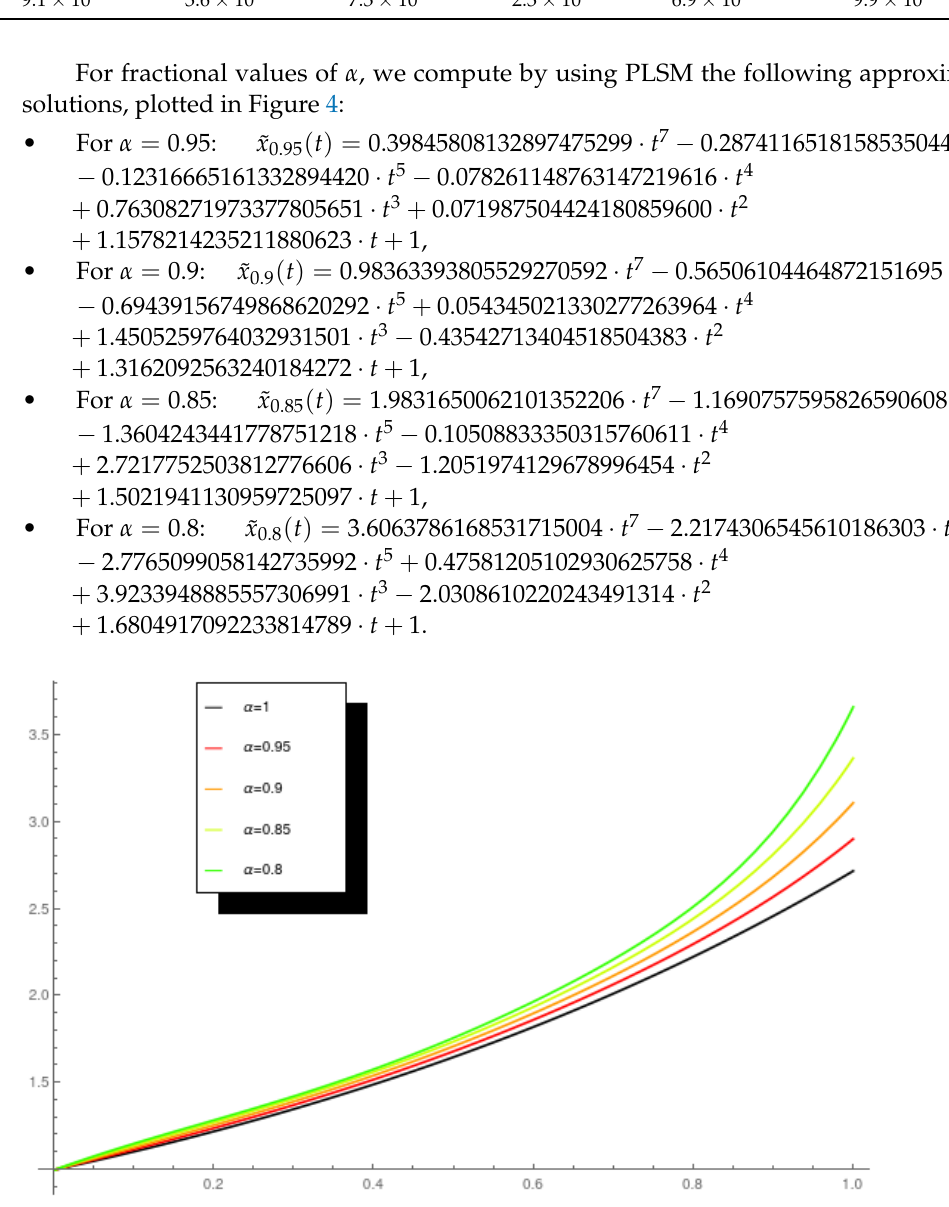
Figure 4. Approximate solutions of (24) for several values of α